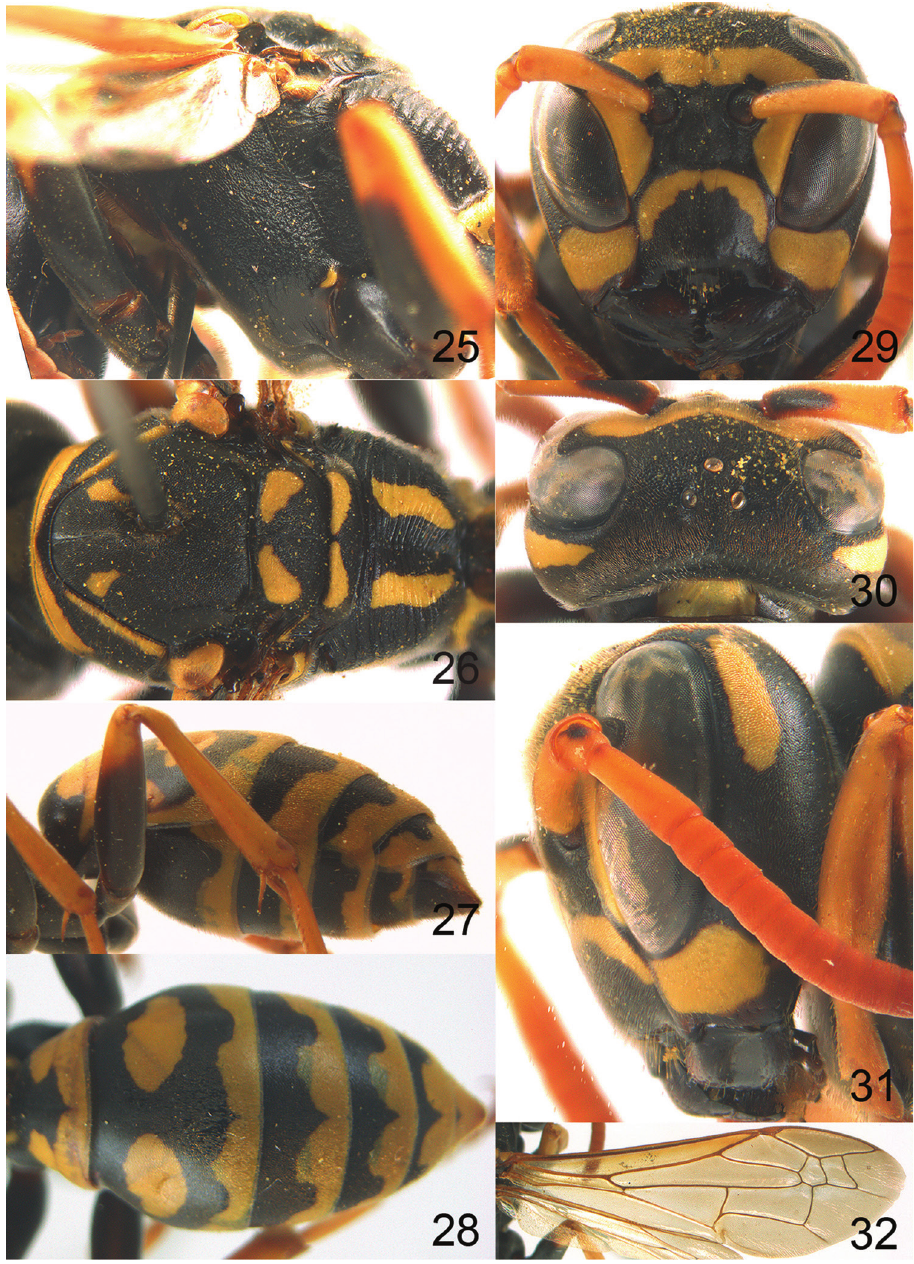
Figures 25–32. Polistes austroccidentalis sp. n. Holotype female. 25 Mesosoma in lateral view, 26 meso- soma in dorsal view 27 metasoma in lateral view 28 metasoma in dorsal view 29 head in frontal view 30 head in dorsal view 31 head in lateral view 32 fore